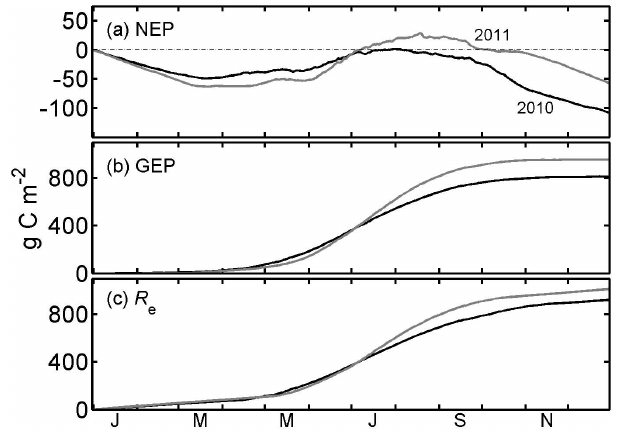
Fig. 7. Relationship between nighttime ecosystem respiration ( R e ) with friction velocity threshold ( u ∗ th ) applied ( u ∗ th = 0.2ms − 1 ) and 3cm soil temperature ( T s ) in 2010 and 2011. Each data point is an average of 10 half-hour values. The equation parameters are given in Table